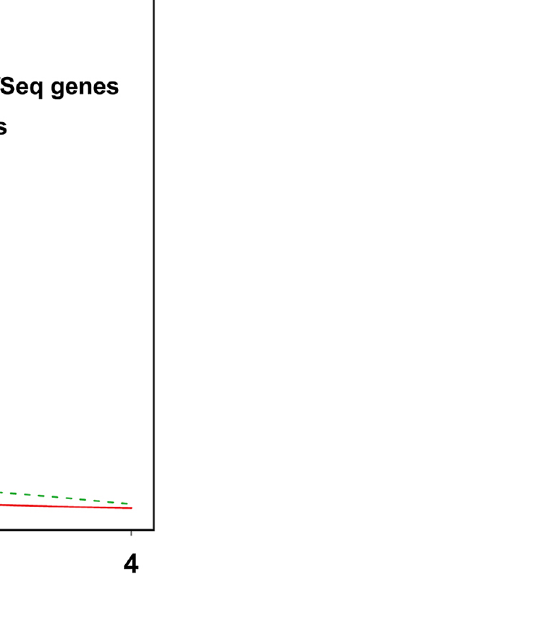
Figure 7. Multicopy genes show evidence of altered selective pressures on amino acid sequence during recent primate evolution. Density plots showing the distribution of dN/dS ratios for multicopy genes ( green ) compared to all RefSeq genes ( red ) for human versus chimpanzee. There is a significant enrichment for elevated rates of non-synonymous substitution in multicopy genes versus the genome average (p=3.3 6 10 2 7 , Kolmogorov-Smirnov test). This excess of non-synonymous amino-acid changes in recent primate evolution at multicopy genes is consistent with either reduced selective constraint and/or selection for proteins with altered function. Similar results are obtained when comparing human with orangutan and macaque (Figure